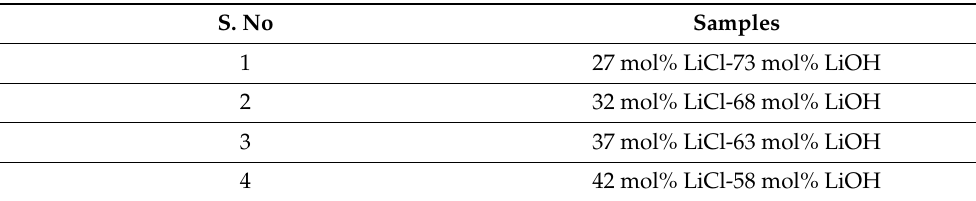
Table 2. List of binary salt mixtures investigated in the current study. S. No